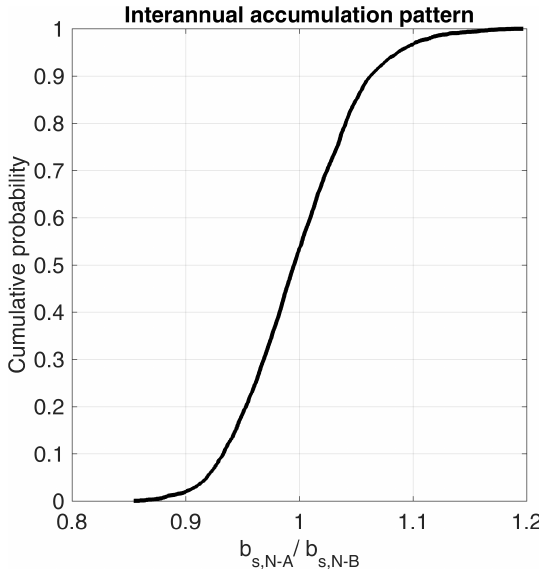
Figure 8. Interannual accumulation pattern comparison for inter- secting transects at DYE-2. b s,N-A corresponds to normalized b s for winter accumulation 2015/2016 and b s,N-B to normalized b s for winter accumulation